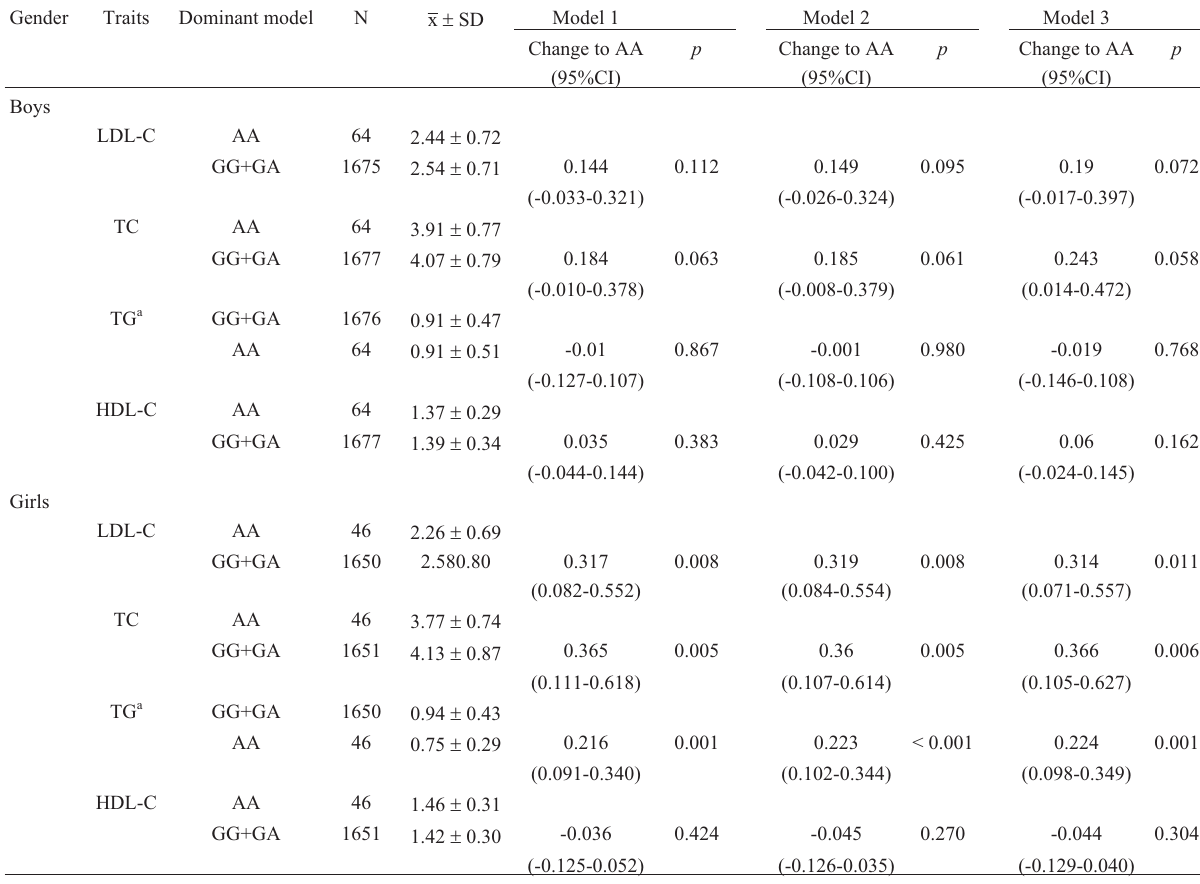
Table 3 - Difference in lipid levels with different genotypes of rs6499640 by gender.